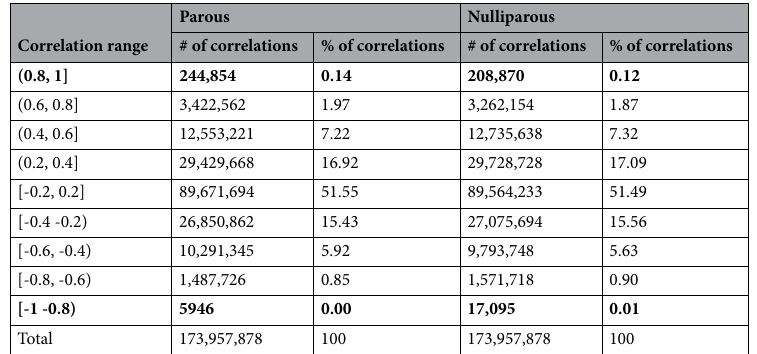
Table 1. Size of the networks for each threshold for parous and nulliparous groups. High-correlation networks are marked in bold.